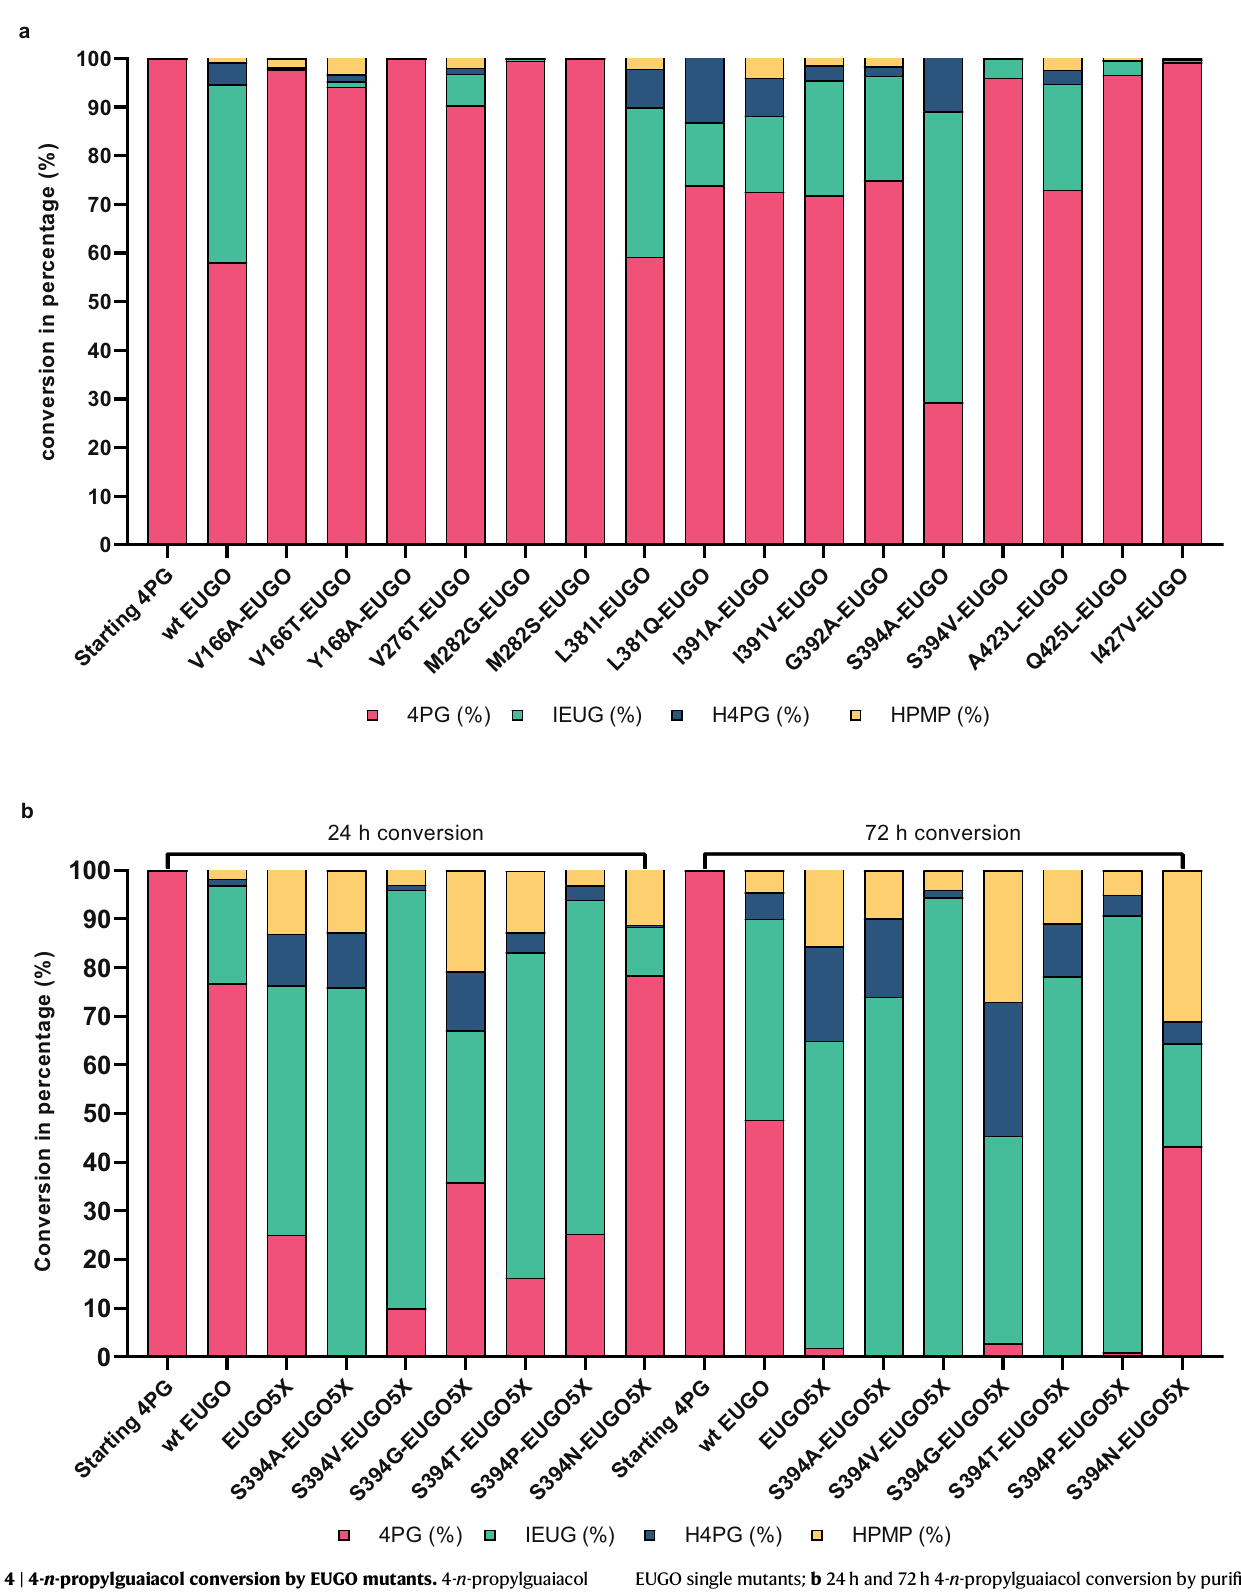
EUGO single mutants; b 24h and 72h 4- n -propylguaiacol conversion by puri fi ed mutants of EUGO5X in order to improve chemoselectivity. Conversions of 4- n - propylguaiacol (5mM) were carried out in the presence of enzyme (10 µ M) in a 50mM KPi buffer containing 10% v/v DMSO at pH